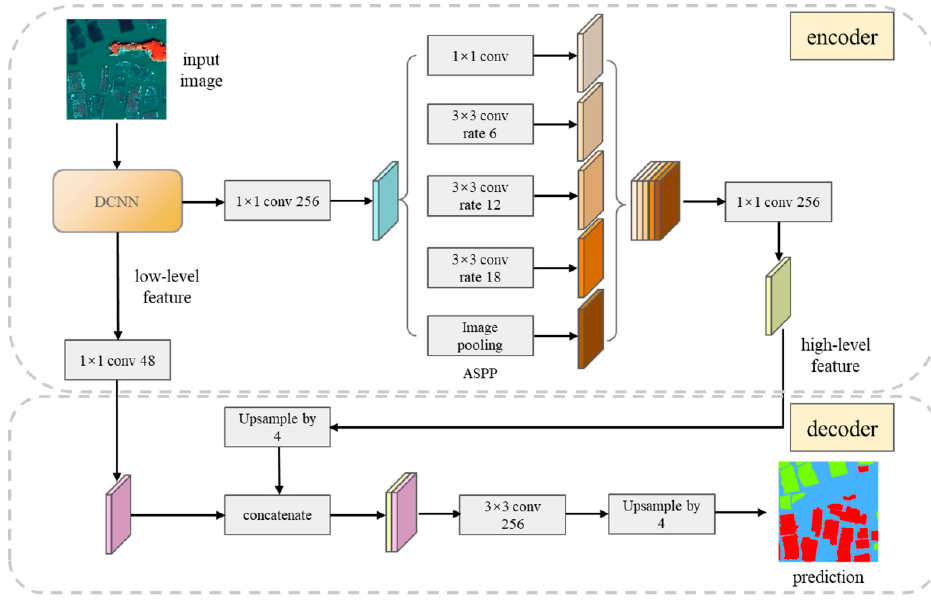
Figure 10. The framework of DeepLab-v3+.